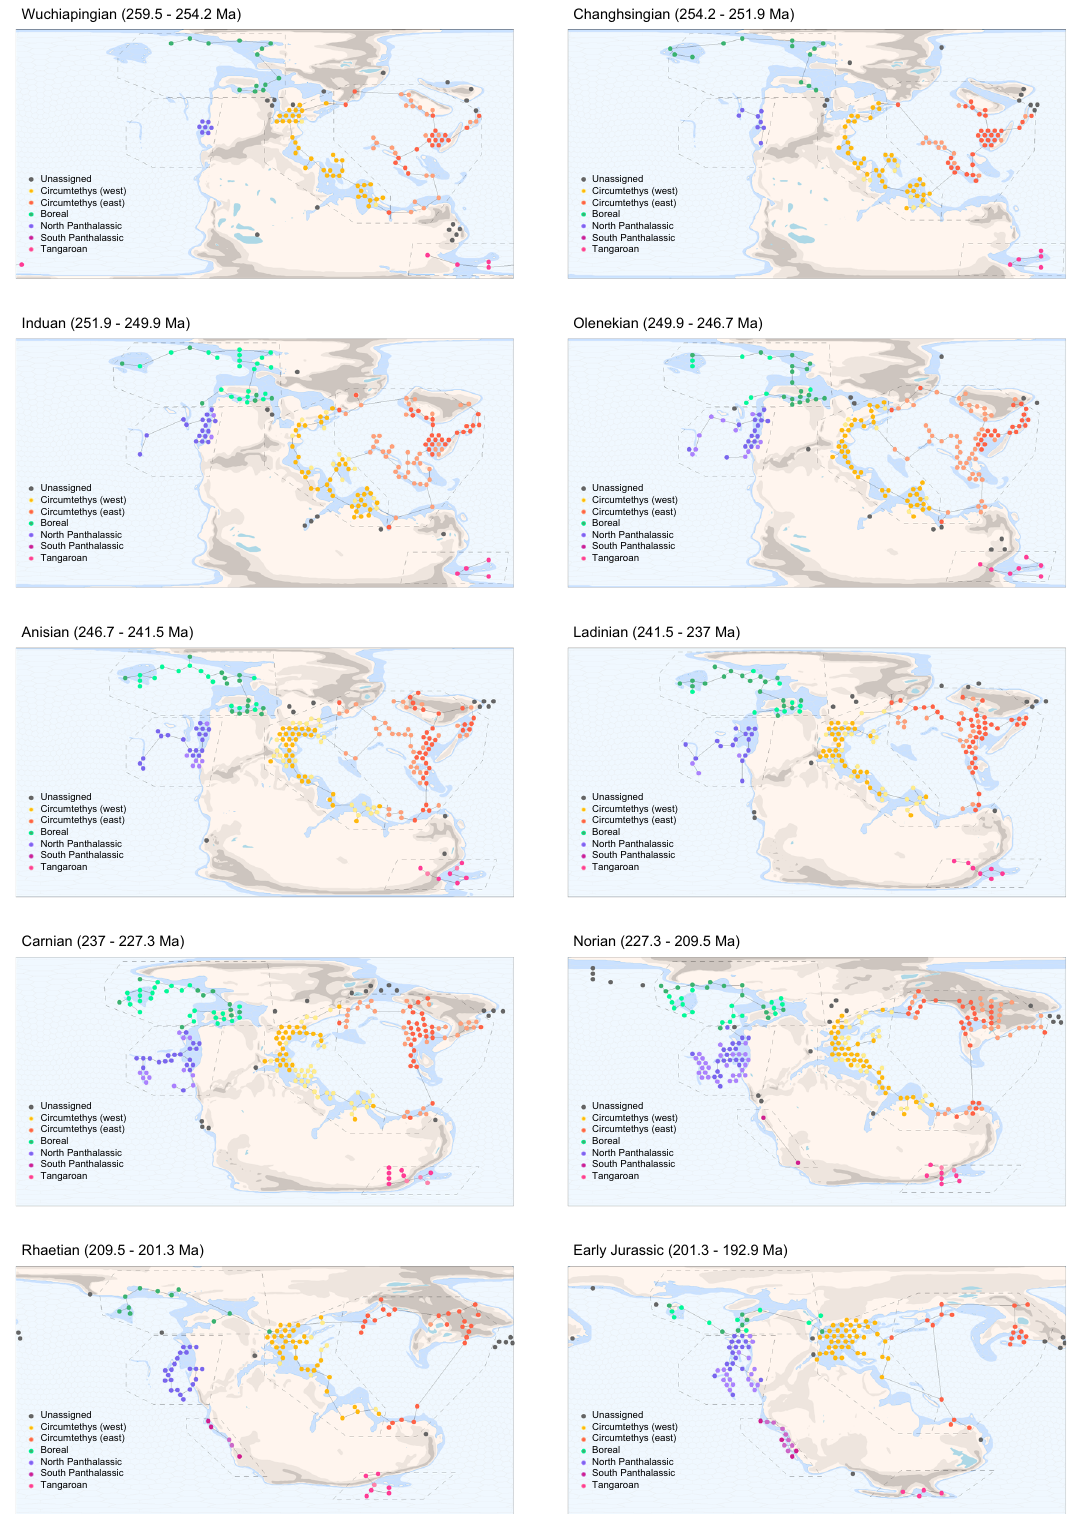
Fig. 1 Spatial standardisation for the Late Permian to Early Jurassic (259.5 – 192.9 Ma). Geographically consistent temporal transects of fossil data were captured using sliding spatial windows which demarcate the bounds of biogeographically important sampling regions through our study interval, then spatially subsampled to give a consistent minimum spanning tree length (MST) in each time bin. Spatially-standardised datasets from each region were used to estimate diversity dynamics corrected for heterogenous sampling through time and across space. Dotted black lines demarcate the sliding spatial windows de fi ning each sampling region, solid black lines their MSTs, coloured points the occupied grid cells comprising the MST, and points with the darker hue those retained after MST